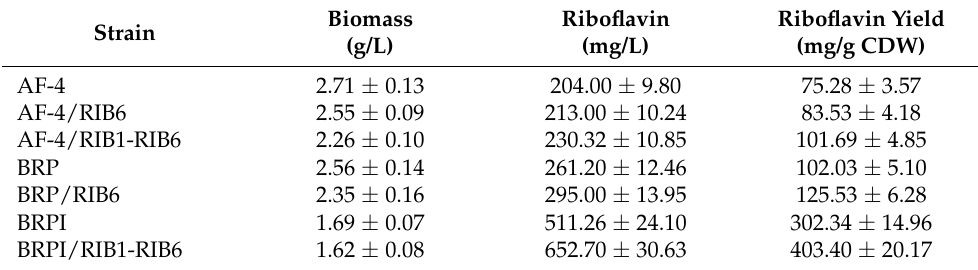
Table 1. Cell biomass, riboflavin production, and riboflavin yield of C. famata strains AF-4, AF-4/RIB6, AF-4/RIB1-RIB6, BRP, BRP-RIB6, BRPI, and BRPI/RIB1-RIB6 in the YNB medium at the fifth day of cultivation.